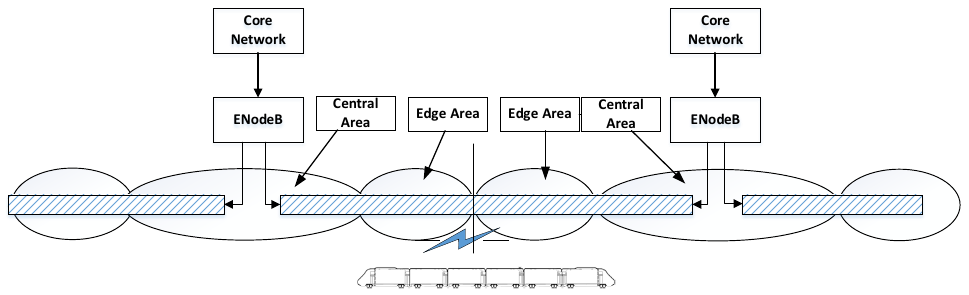
Figure 1. LTE-M Train-wayside Data Communication System in Urban Rail